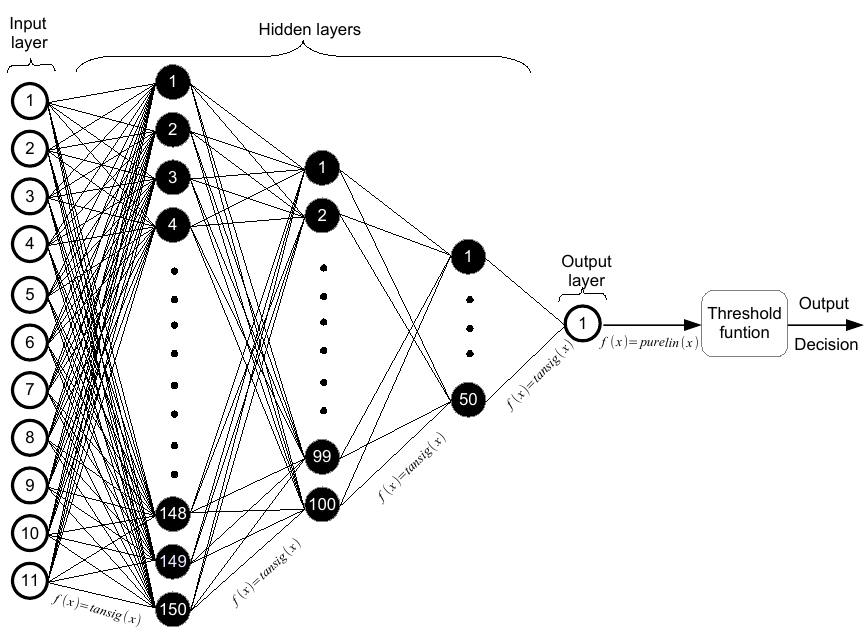
Figure 3. Architecture of the proposed back-propagation ANN